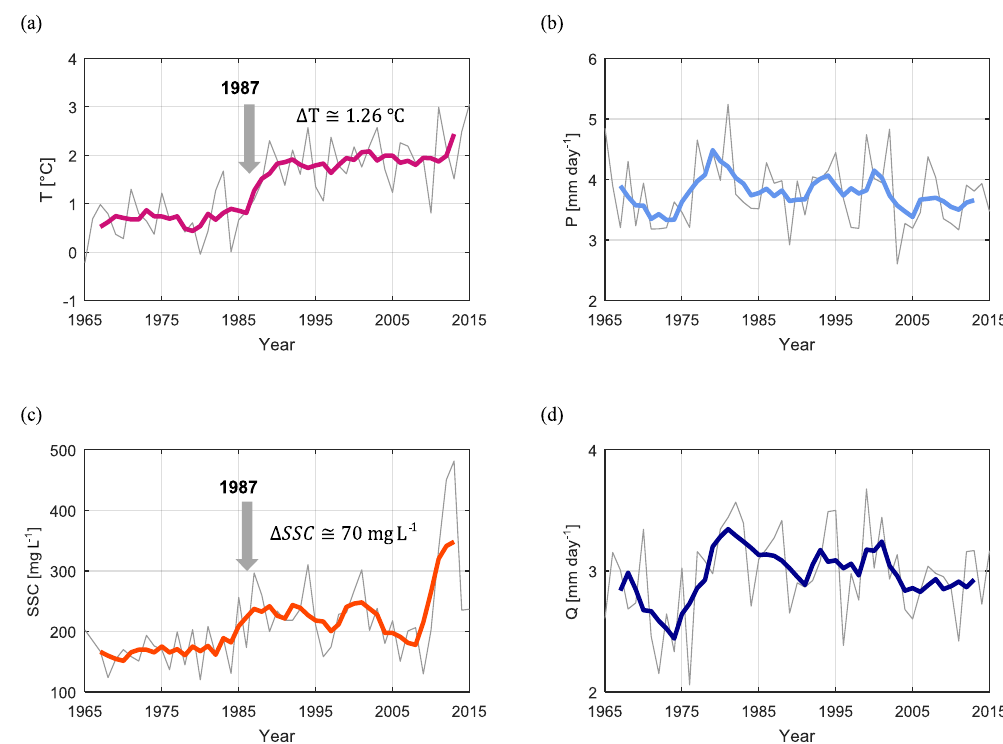
Figure 6. Observations for the period 1965–2015 of (a) basin-averaged air temperature, (b) basin-averaged daily precipitation, (c) suspended sediment concentration measured at the outlet of the basin, and (d) daily discharge per unit area measured at the outlet of the basin. Mean annual values are shown in grey and the 5-years moving average is shown with a bold